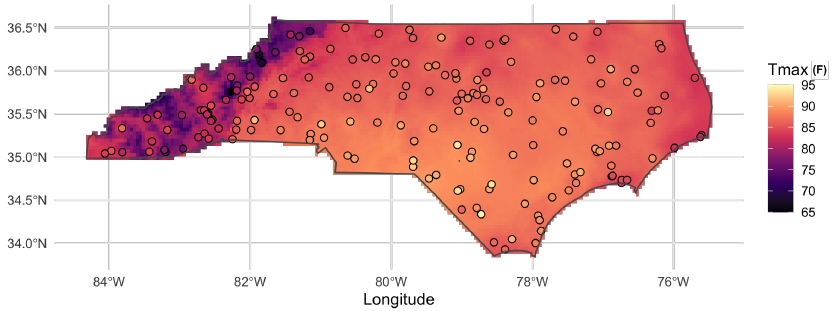
Figure 1. Average daily maximum June air temperature values between 2014 and 2020 for GHCN stations and GridMET cells across North